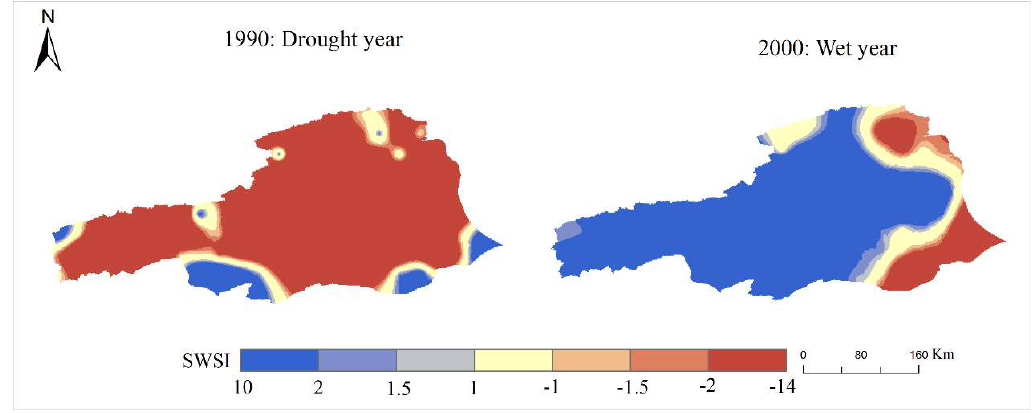
Figure 5. The spatial pattern of hydrological drought (HD) in drought year (1990) and wet year (2000).